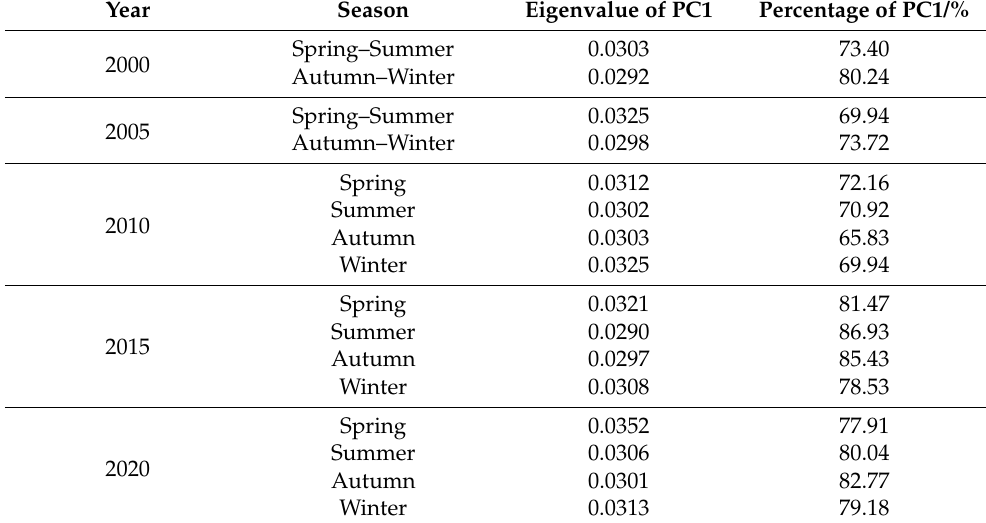
Table 5. Each ECEI season’s SPCA